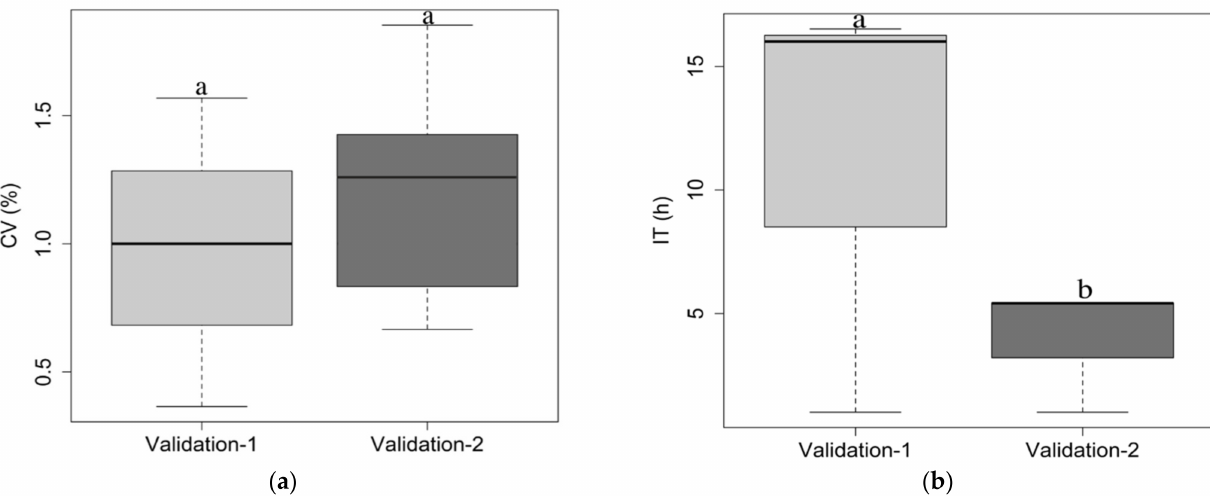
Figure 4. Box-plots showing: ( a ) The CV (%); and ( b ) IT (h) distributions in Validation-1 and Validation-2. The median is represented as a thick horizontal black line, upper and lower quartiles as a box with the maximum and minimum measurements as lines protruding from these. Box-plots followed by a different letter within each boxplot set are significantly different between each other ( p -value ≤